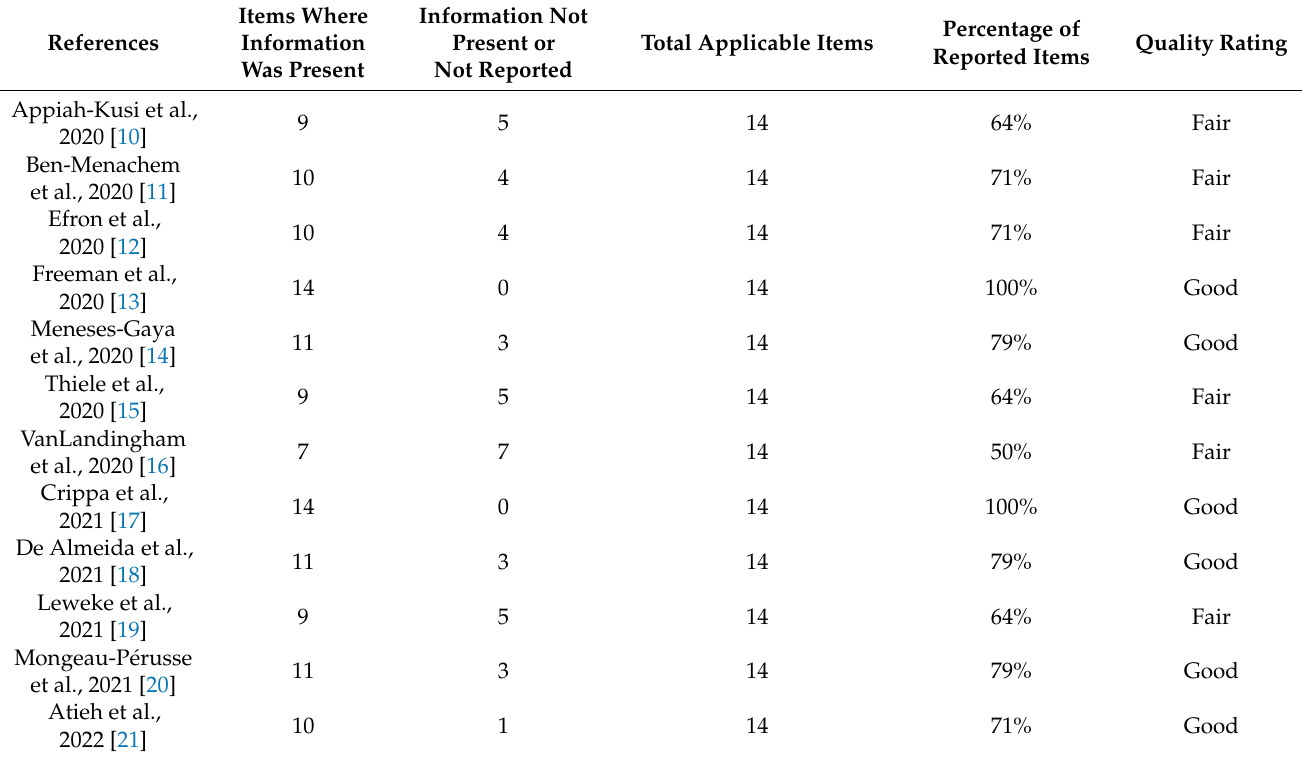
Table 4. Summary of the analysis of the studies’